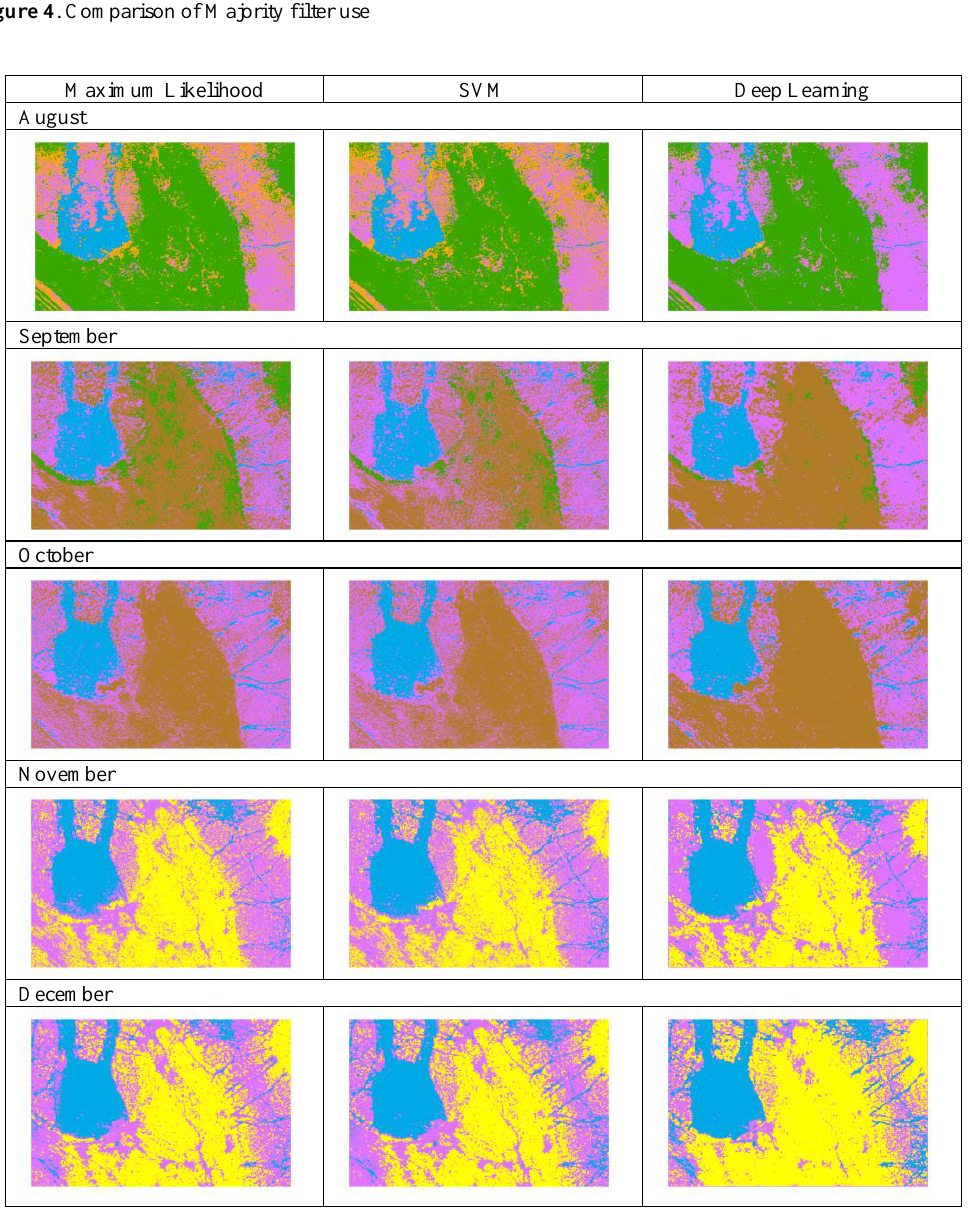
Figure 5 . Results from supervised